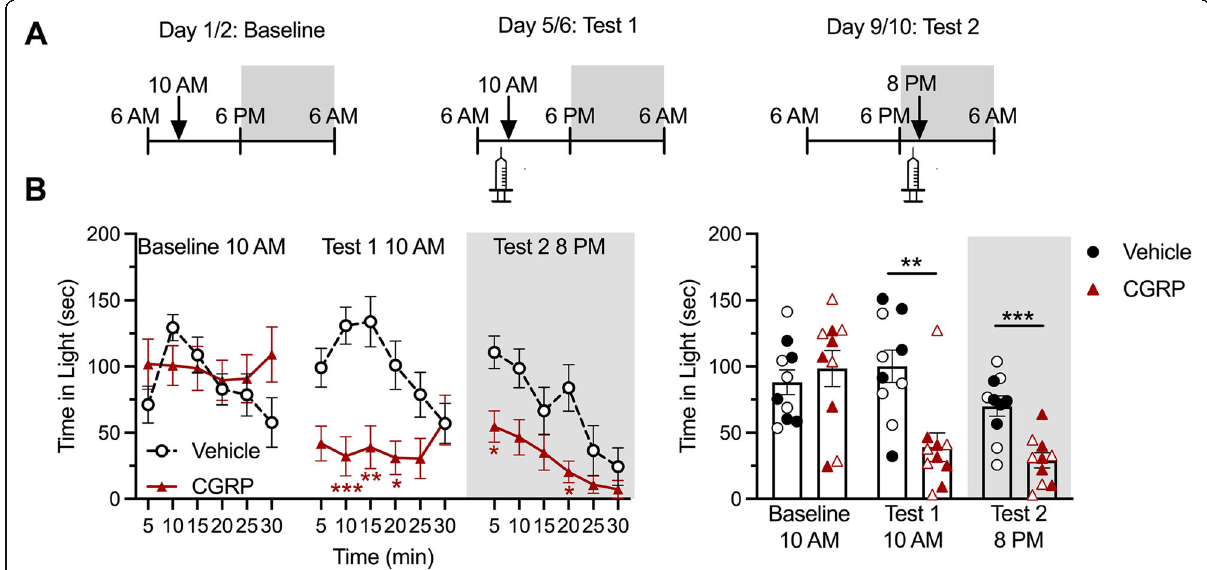
Fig. 3 Peripheral CGRP induces light aversion during both the inactive and active phases. In all panels, grey areas represent the active phase of the animals when lights of the facility were turned off (night). Empty symbols represent females, and full symbols represent males. There were no statistical differences between males and females. A Experimental design: mice were first baselined during their inactive phase (experiment starting at 10:00am), and then exposed to treatments on the first test day during their inactive phase (10 am), and second test day during their active phase (experiment starting at 8:00 pm). B Left panel. Time spent in the light zone by CD1 mice during sequential exposures to the light/ dark chamber at 25,000 lx. On test days, animals were tested 30 min after injection of vehicle (PBS, i.p., n = 10) or CGRP (0.1 mg/kg i.p., n = 10). Two-way (factors: time x treatment) ANOVA Sidak ’ s multiple comparison test * p < 0.05, ** p < 0.01 and *** p < 0.001 compared to corresponding time point in vehicle group. Right panel. Mean time (± SEM) spent in the light zone per 5 min interval for individual mice during the same experiment represented in (A). Unpaired t-test ** p < 0.01 and *** p < 0.001 comparing CGRP group with corresponding vehicle group. C Mice were first baselined during their active phase (experiment starting at 8:00 pm), and then exposed to treatments on the first test day during their active phase (8 pm), and second test day during their inactive phase (experiment starting at 10:00am). Two-way (factors: time x treatment) ANOVA, Sidak ’ s multiple comparison test * p < 0.05, ** p < 0.01 and *** p < 0.001 compared to corresponding time point in vehicle group. D Mean time (± SEM) spent in the light zone per 5 min interval for individual mice during the same experiment represented in (C). Unpaired t-test ** p < 0.01 and *** p < 0.001 comparing CGRP group with corresponding vehicle